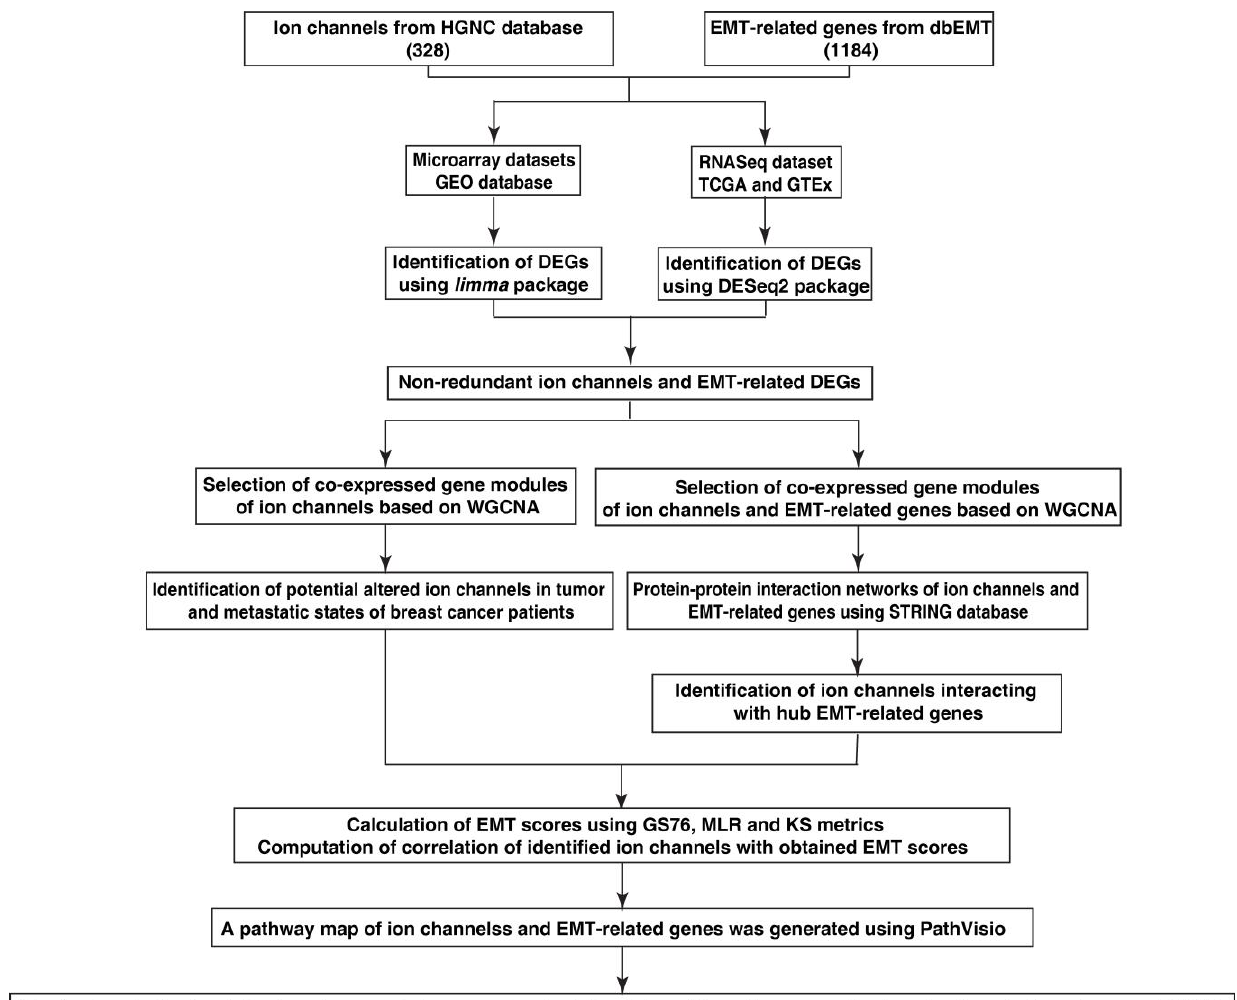
Figure 1. Workflow for the identification of potential ion channels and its interaction with EMT- related genes in tumor and metastatic samples of patients with breast cancer.